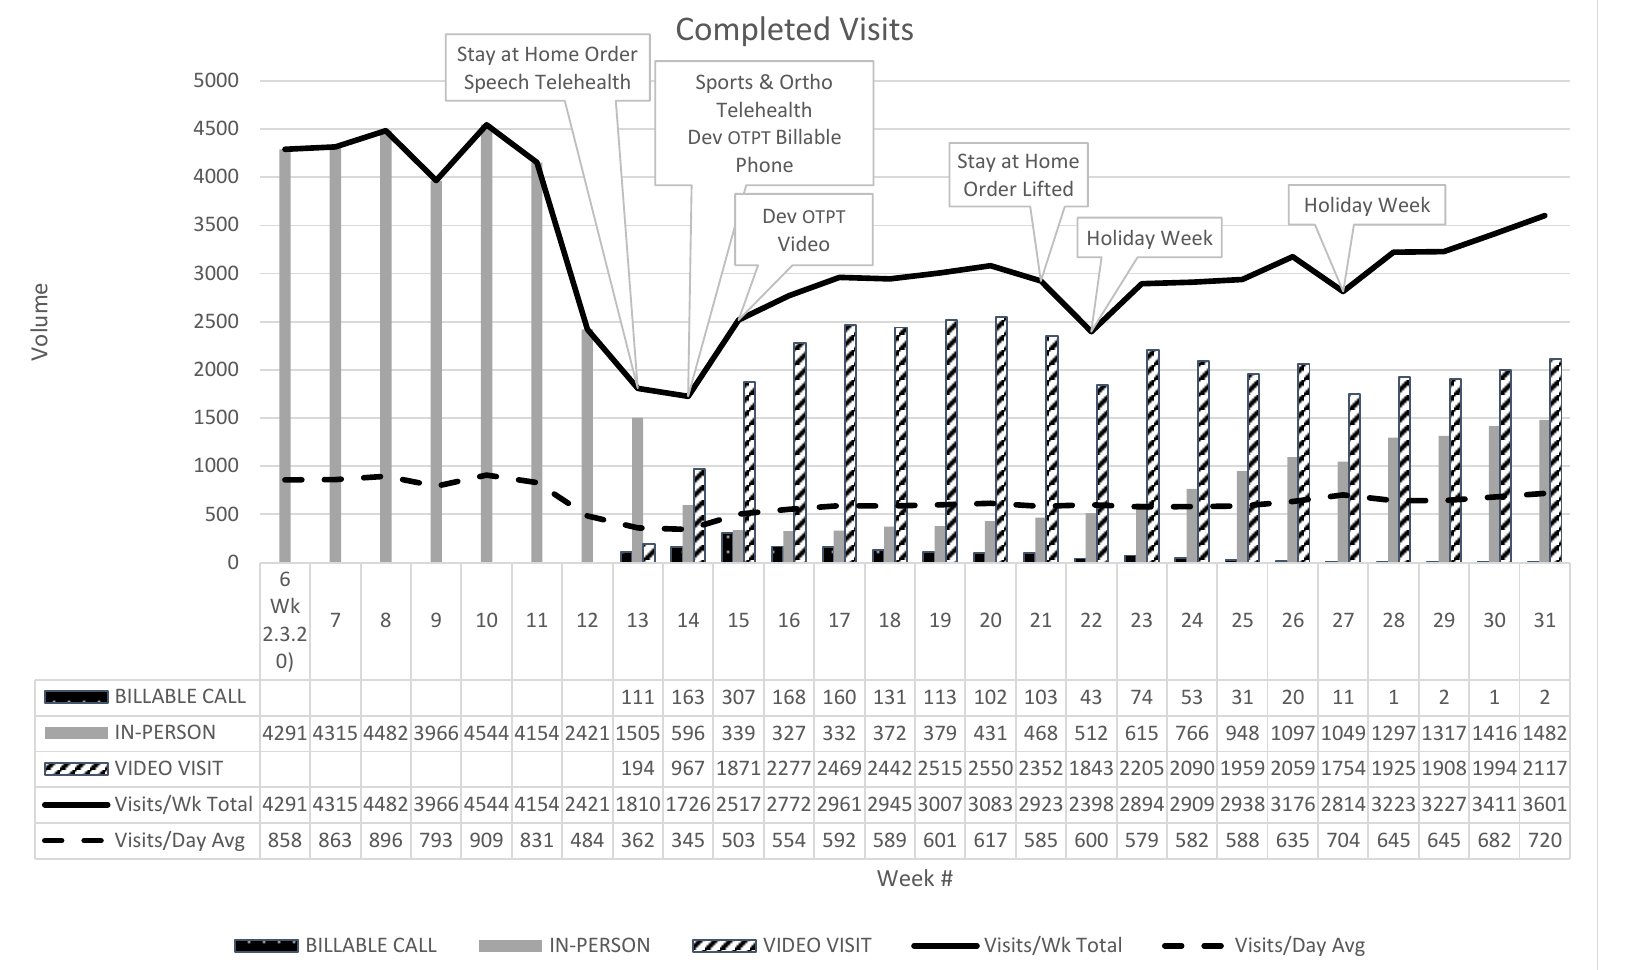
Note . Speech= Speech Pathology Department; Sports & Ortho= Sports and Orthopedic Therapies Department; Dev OTPT= Developmental OT and PT